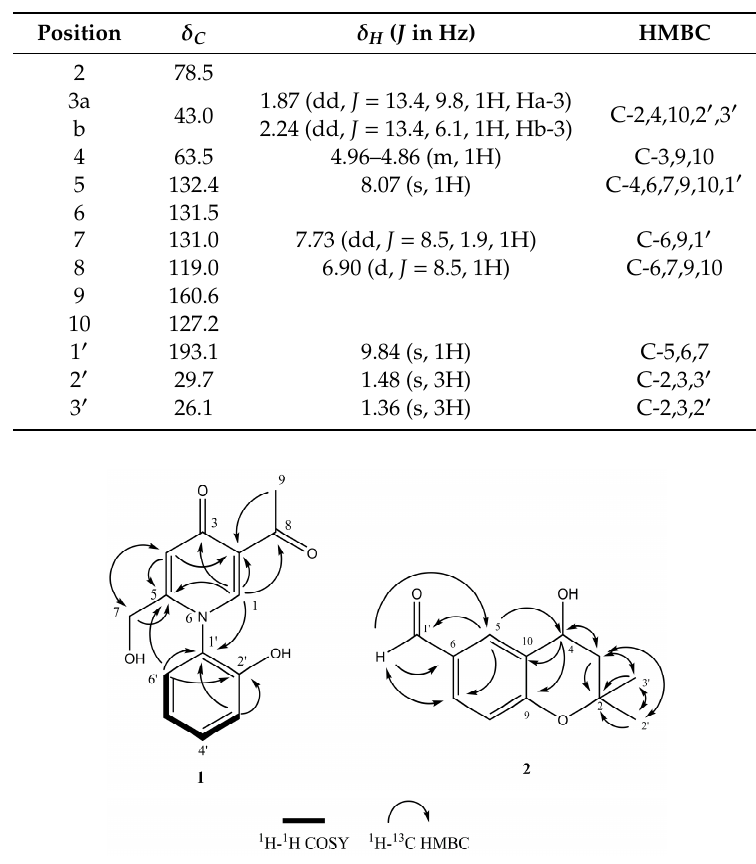
Table 2. 1 H, 13 C NMR, and HMBC data of compound 2 (400 MHz, 100 MHz; CD 3 OD).